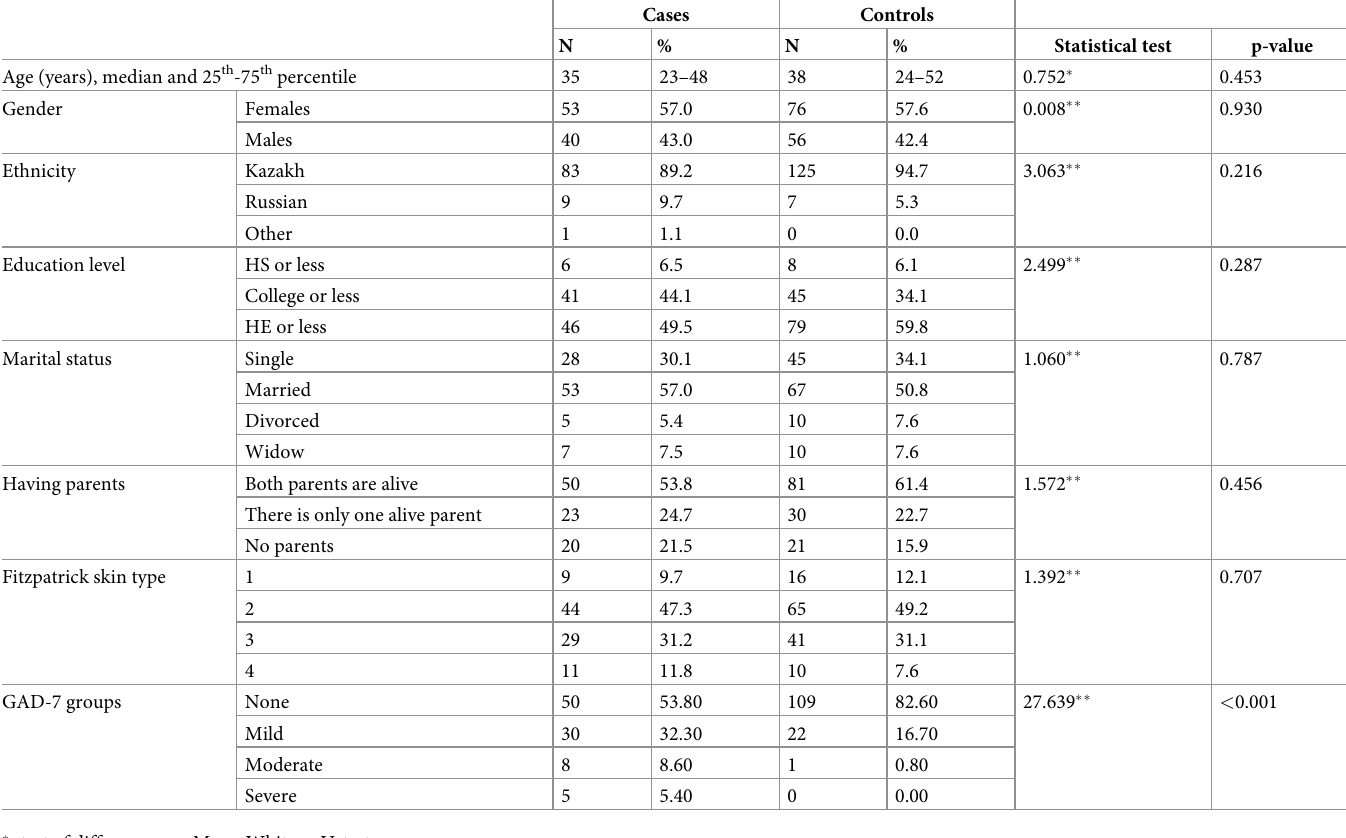
Table 1. Demographic and clinical characteristics of the study participants.